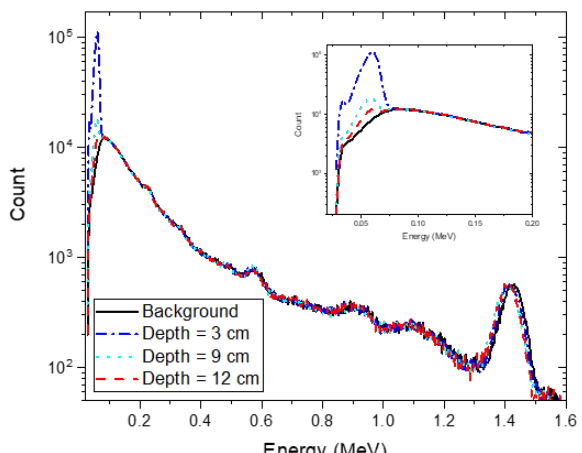
Figure 5. Experimental spectra with an acquisition time of 30 min for an Am-241 source buried in sand at depths of 3 cm (blue dash-dotted line), 9 cm (sky-blue dotted line) and 12 cm (red dashed line). The black solid line represents the background spectrum with the same acquisition time. The inset shows the enlargement of the spectra in the low-energy